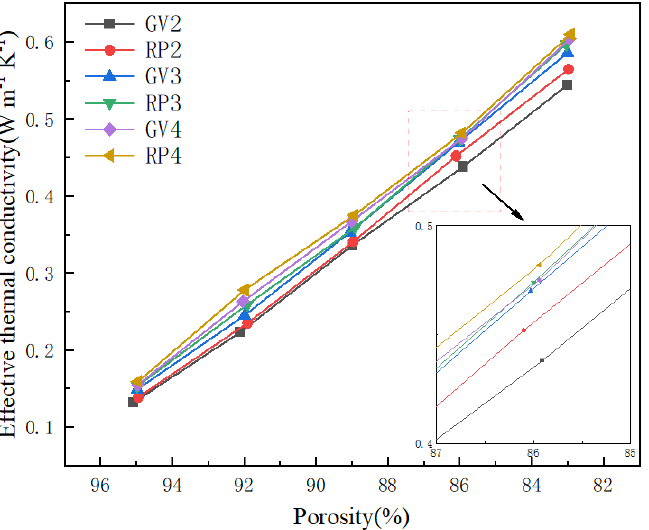
Figure 11. Curve of effective thermal conductivity with porosity for different